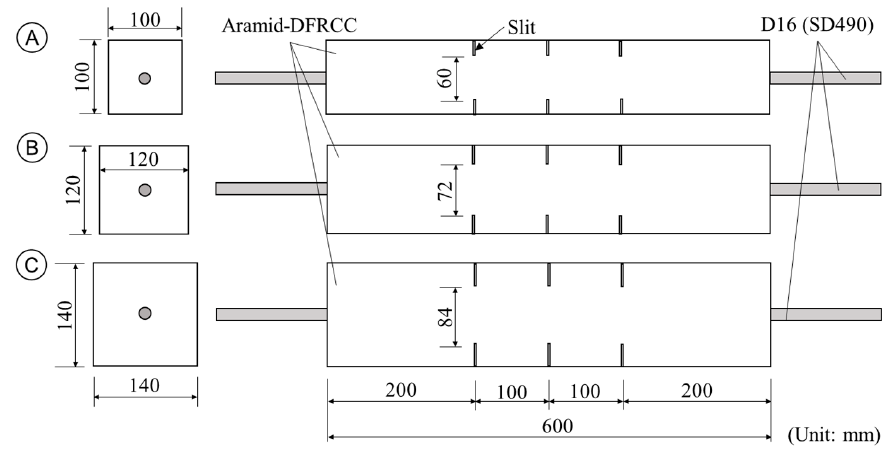
Figure 8. Dimension of specimens [24]. Table 2. List of